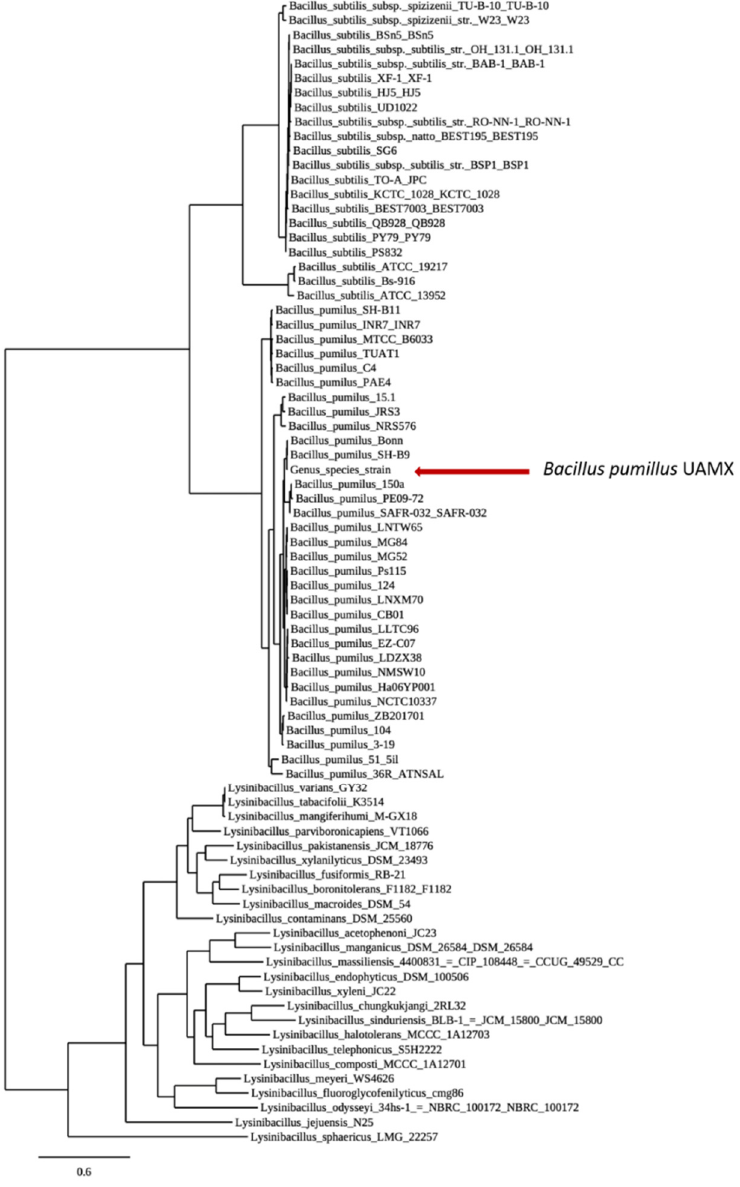
Figure 4. Pangenome tree for B. pumilus UAMX. Built with the closed genomes of B. cereus , B. pumilus , and genus Lysinibacillus strains. Table 2. Average COG categories and proteins of Bacillus pumilus